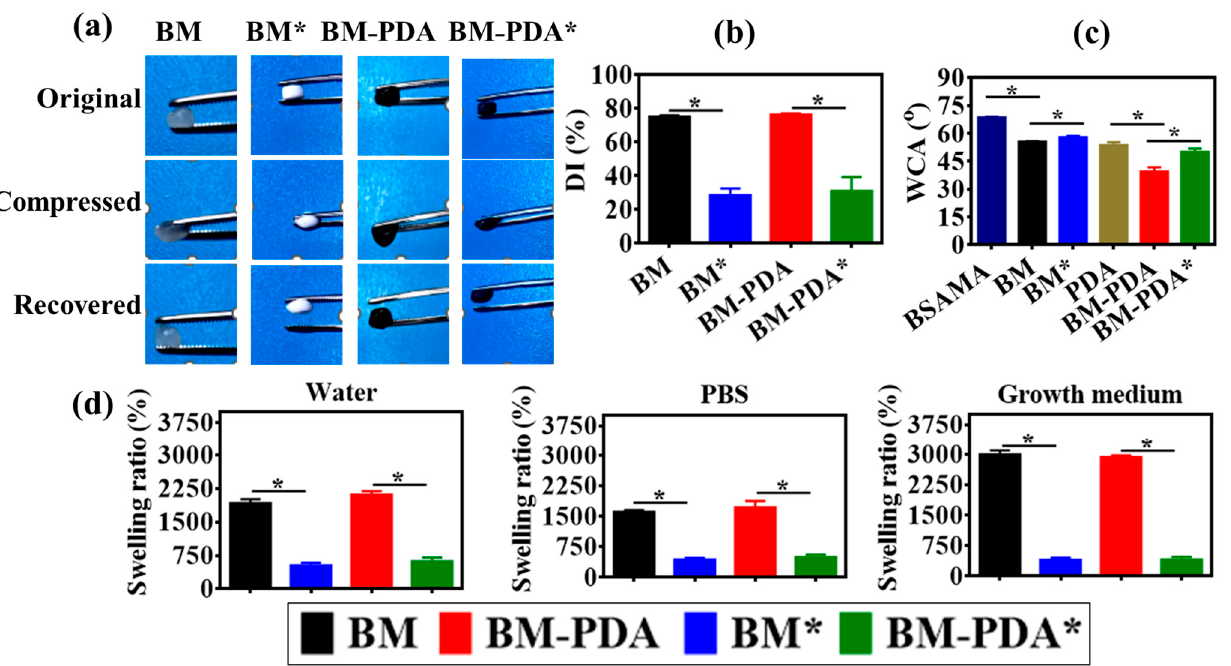
Figure 6. The physiological characteristics of the pristine and mineralized scaffolds in terms of ( a ) shape recovery, ( b ) percent degree of pore interconnectivity (DI), ( c ) water contact angle (WCA), and ( d ) swelling ratio. * P value ≤ 0.0001.